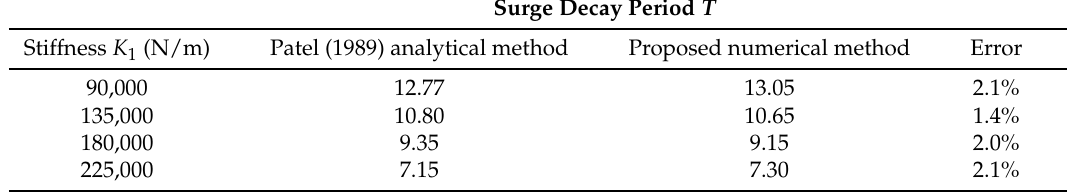
Table 1. Comparison of surge decay period T between Patel (1989) analytical method and proposed